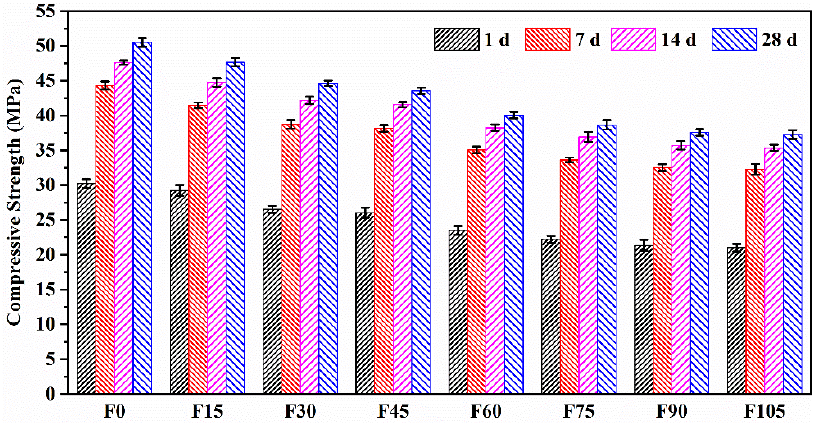
Figure 6. Compressive strengths of F0–F105.